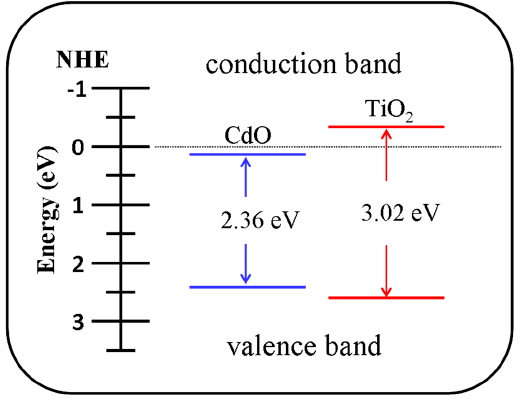
Figure 8. Energy diagram of the TiO 2 and CdO phases.